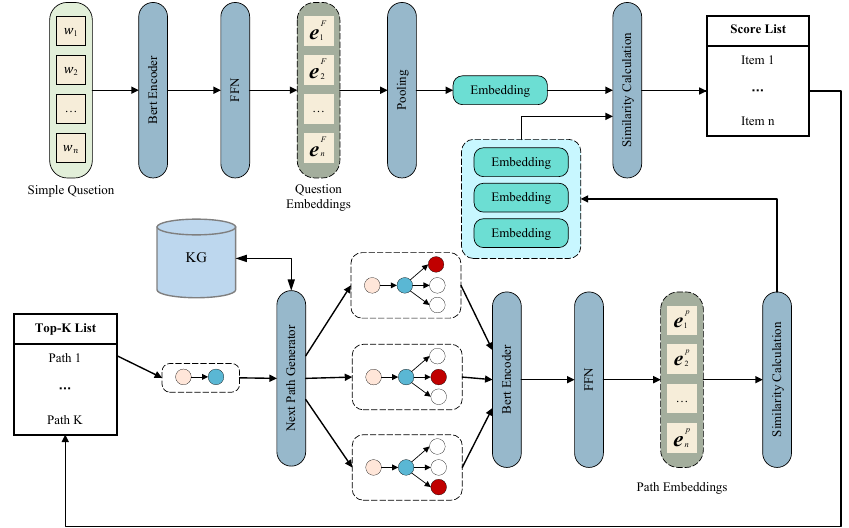
Figure 5. The structure of